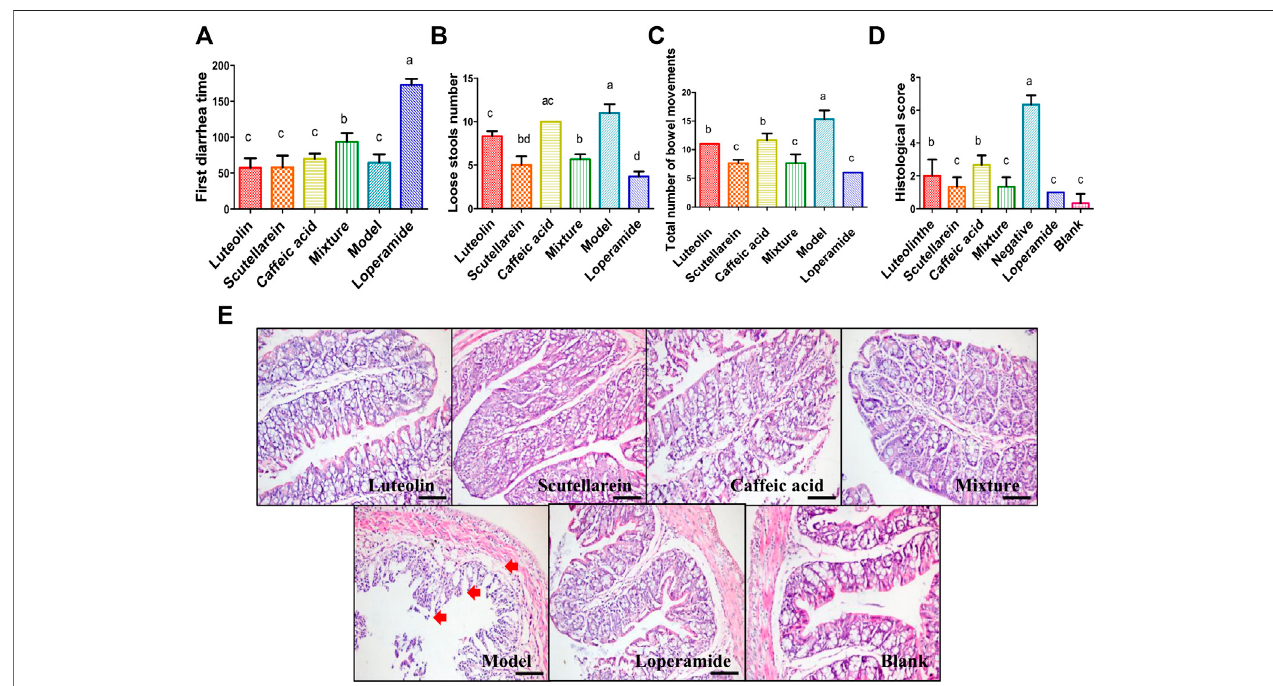
FIGURE3| Theevaluationofantidiarrheaactivitiesoftheeffectivecomponents of Plantago asiatica L. (A – C) Theantidiarrhealeffectofthreeactive ingredients and their mixture was compared with model and positive group. (D) The histological score of different groups, a high histological score indicates a serious histological injury. (E) Thepathologicalsectionofmousecolontissue.Resultsarepresentedasmeans ± SDfrom fi vegroups.Differentsmalllettersuperscriptsinthesamecolumnindicate signi fi cant differences at p < 0.05.